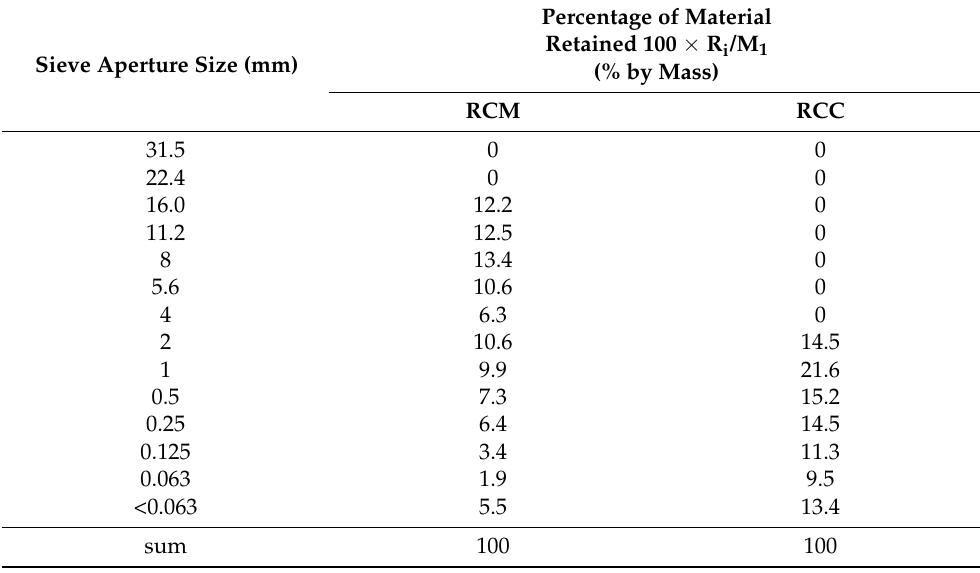
Table 1. Grading of reclaimed cement material (RCM) and reclaimed cement concrete (RCC).